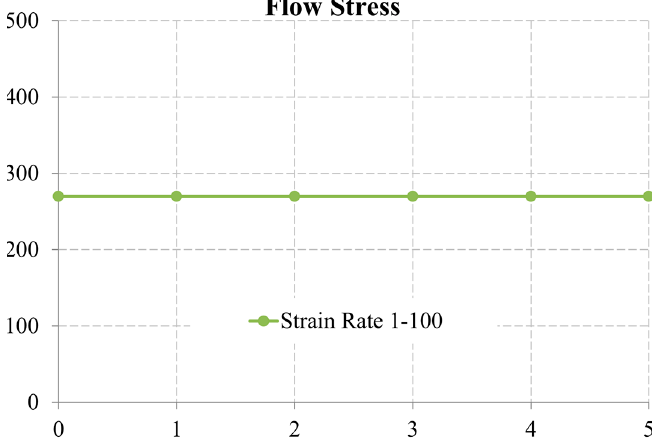
Figure 6. Material flow law. Table 1. General simulation settings.